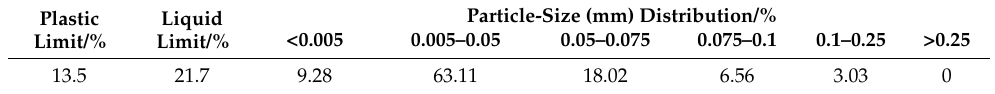
Table 1. The physical parameters of the tested